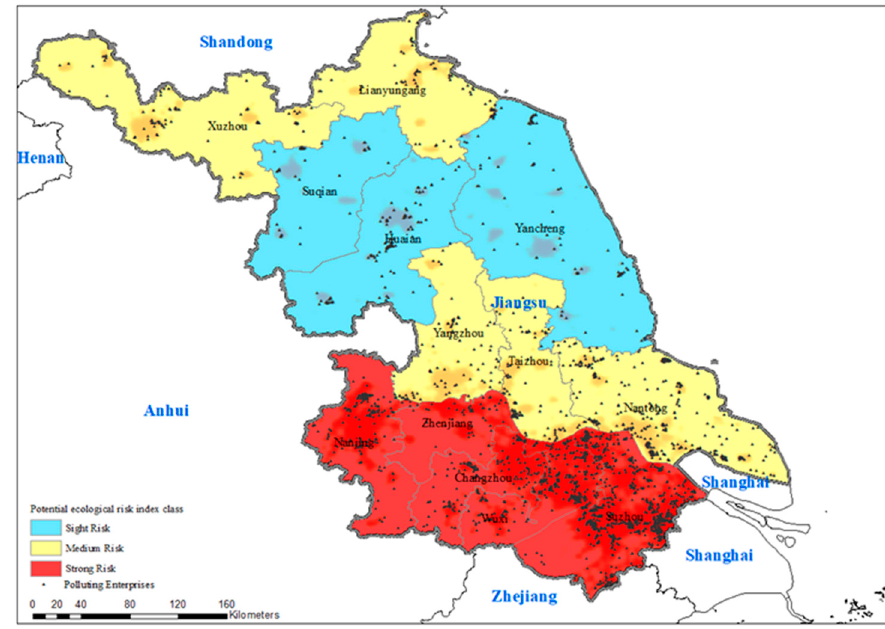
Figure 3. Spatial distribution of potential ecological risk index for heavy metals.